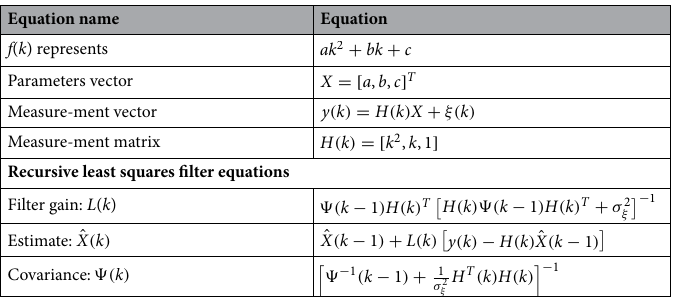
Table 1. Summary of RLS filter equations for proposed